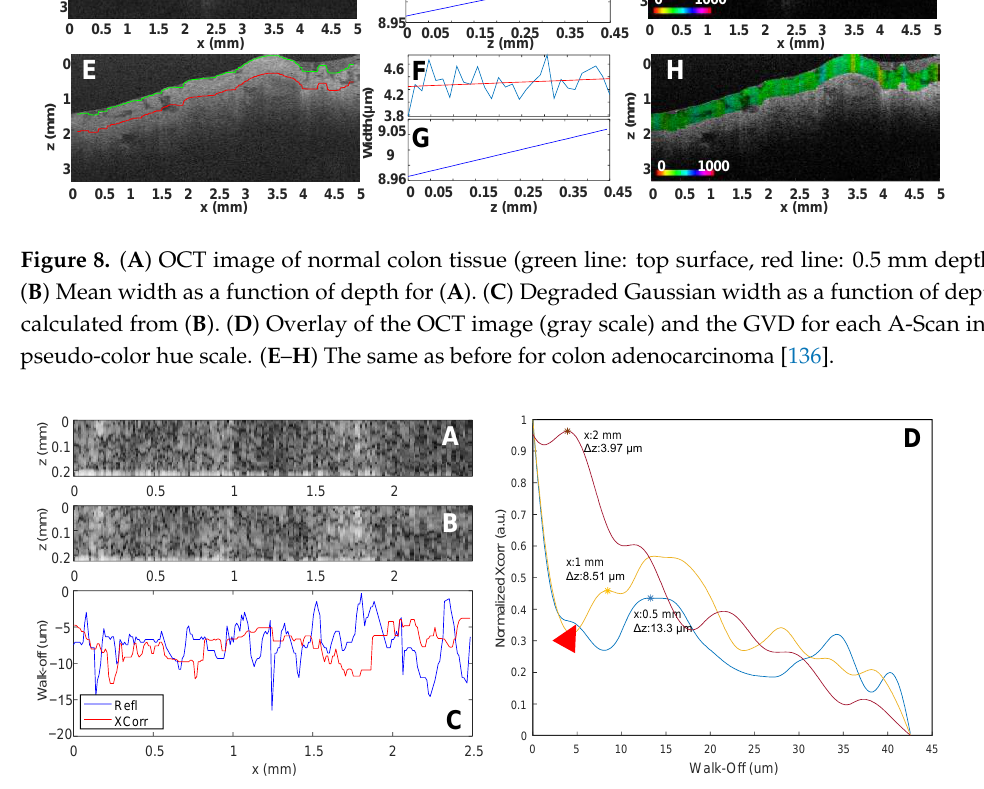
Figure 9. ( A ) Portion of the first half-spectrum OCT image from just above the bottom surface of the sample. ( B ) Similar portion from the second half-spectrum OCT image. ( C ) The walk-off for the 250 A-Scans in (A) and (B) calculated from the cross-correlation (red line). The blue line is the reference walk-off from the reflector. ( D ) Three indicative cross-correlation curves from different locations (x): 0.5 mm (blue), 1 mm (yellow) and 2 mm (red). The stars indicate the first maximum and the associated walk- off (Δz). The red arrow points to the location where the maximum should occur, which was missed due to weak cross correlation, a cause of error in the estimations [139].